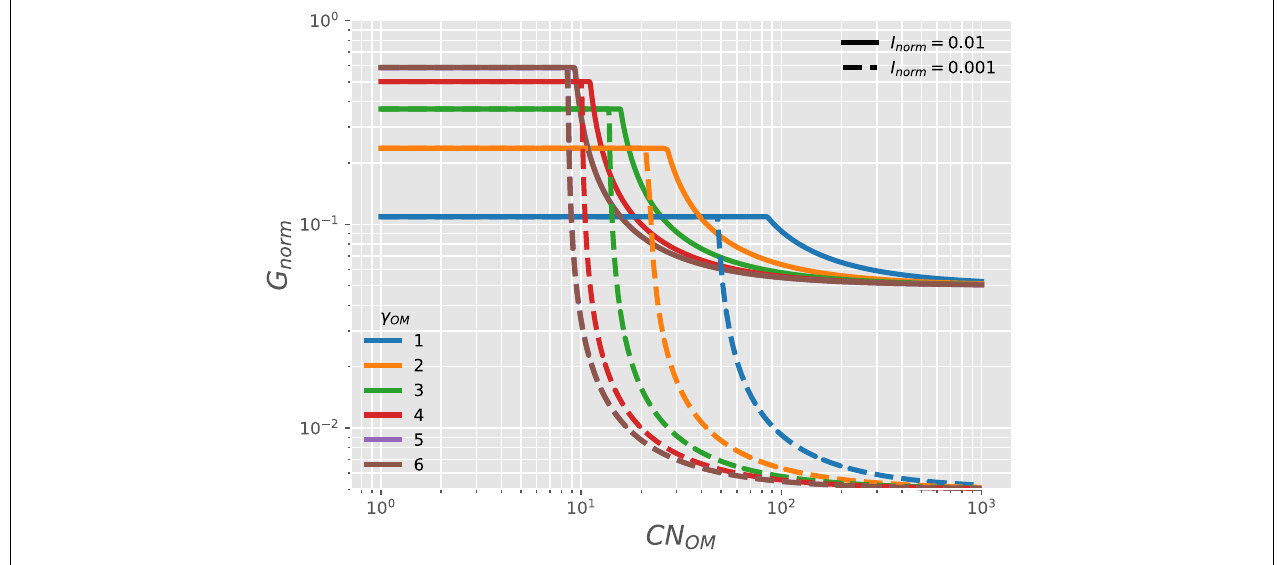
FIGURE 6 | OM containing N: variation of normalized microbial growth rate ( G norm ) along a gradient of OM C:N ratio [ CN OM in C-mol (N-mol) − 1 ] under oxic conditions, and with varying degree of reduction of the OM ( γ OM ; curves with different colors) and two levels of N Inorg -availability ( I norm , solid vs. dashed curves). For γ OM > 5, curves are close to each other so that the curve for γ OM = 5 is not visible and is below the brown